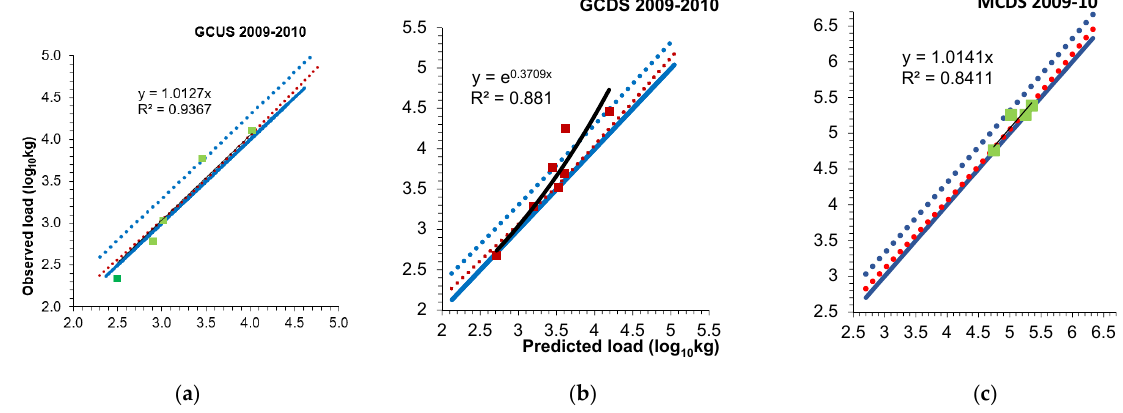
Figure 9. Relationship between OTL and PTL at GCUS ( a ), GCDS ( b ), and MCDS ( c ) (2009–2010). See Figure 7 for the explanation of the lines and colors of the points.